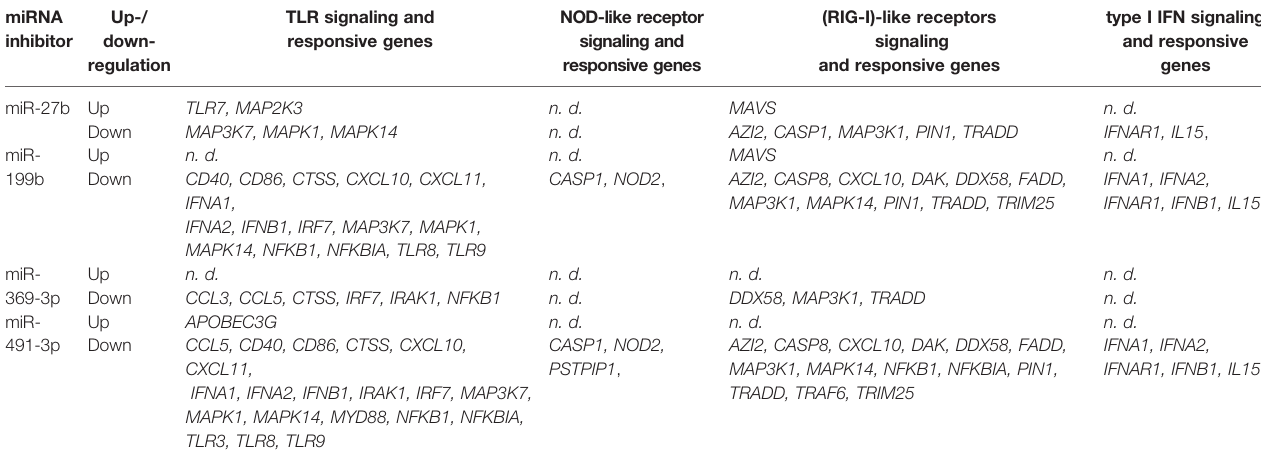
TABLE 2 | Expression of antiviral response genes signi fi cantly altered in NK-92 cell line treated with each miRNA inhibitor in comparison to the negative control inhibitor. miRNA Up-/ inhibitor